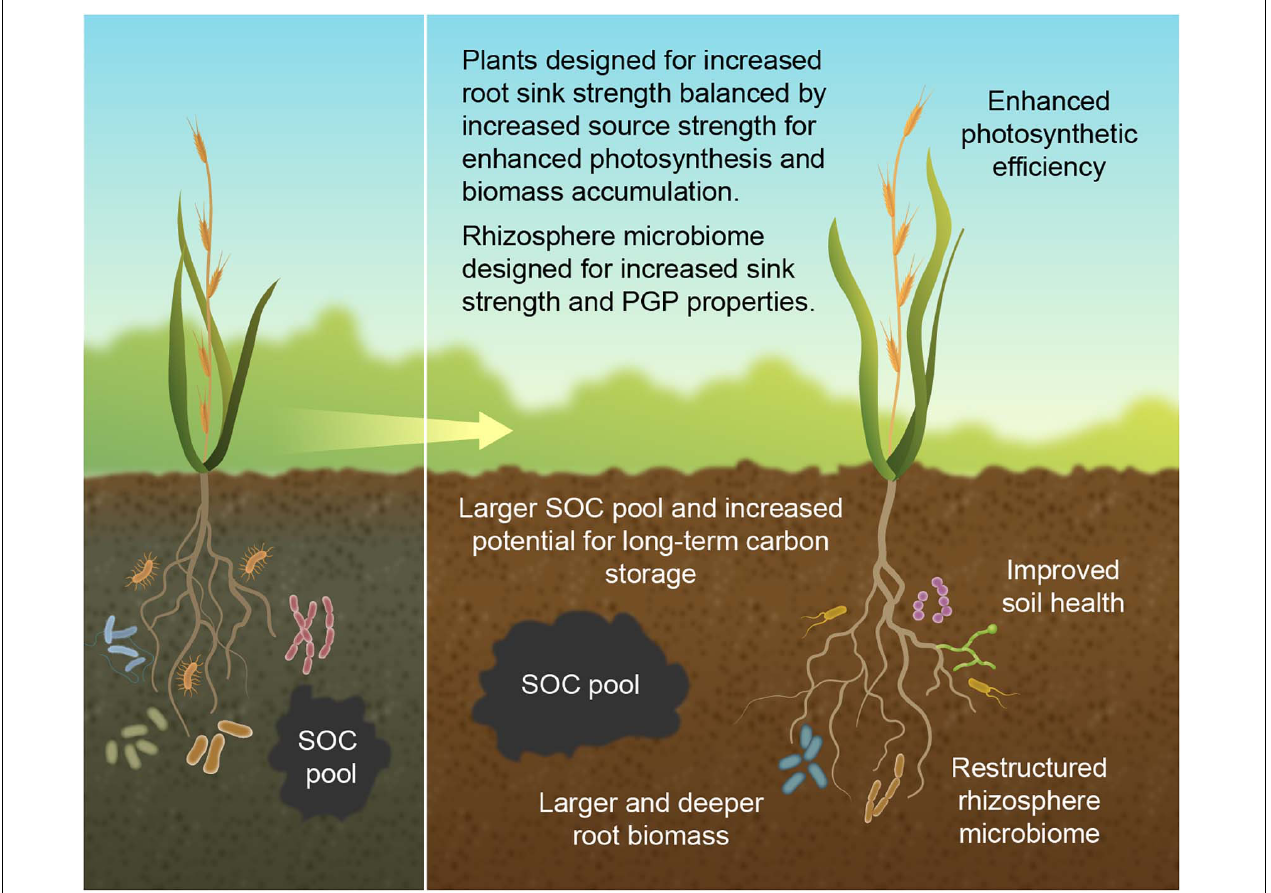
FIGURE 4 | Rationale for designing an integrated plant-microbe-soil system with the dual goal of improving the soil carbon budget while maintaining crop yield, showing current crop (left panel) and desired crop ideotype (right panel) . Larger root biomass confers increased sink strength that funnels more carbon to the soil, and deeper roots increase the likelihood for long-term soil carbon storage. Custom-made rhizosphere microbiomes are designed to further augment the demand for belowground carbon, thereby increasing the rhizosphere sink strength, while also providing PGP properties. To complement promotion of plant productivity from improved soil health, PGP microbes, and enhanced photosynthesis by increased sink demand, plants are also designed for increased source strength to further enhance photosynthesis and biomass